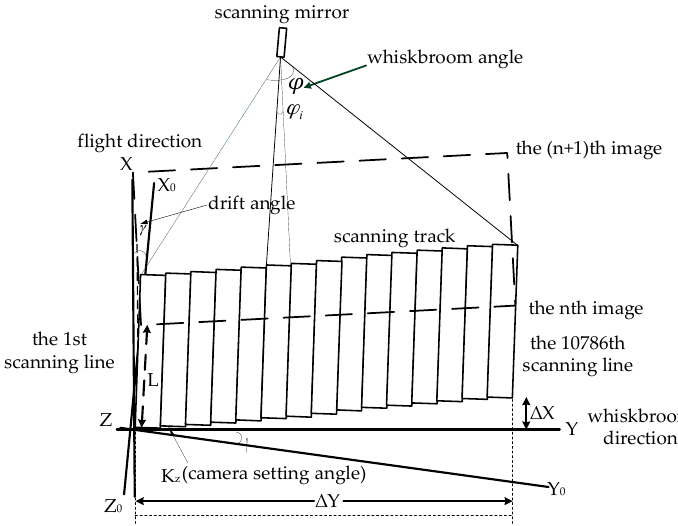
Figure 1. The scanning image of the thermal-infrared linear array whiskbroom camera.